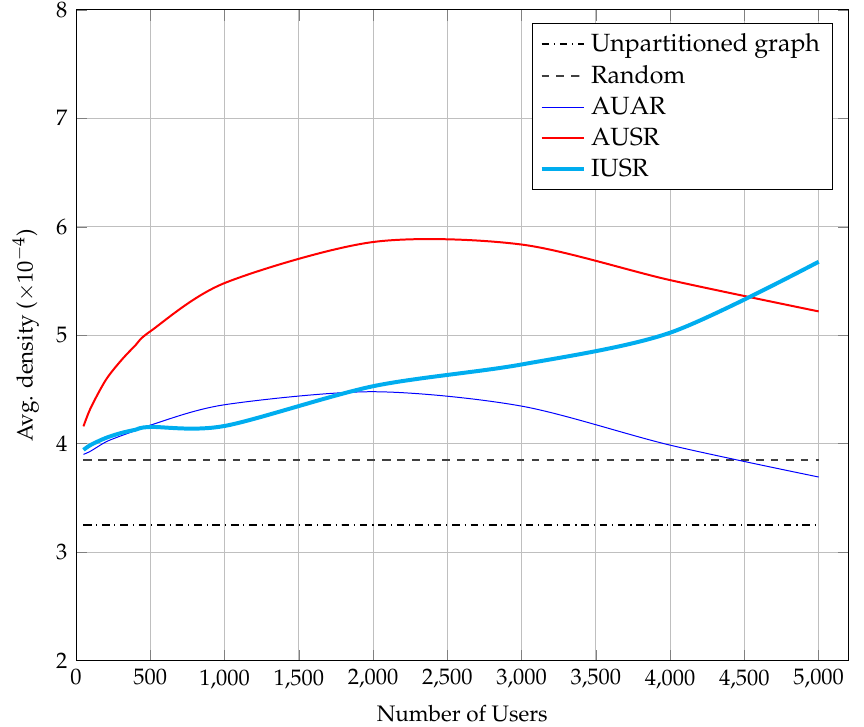
Figure 3. Average density per partition for different numbers of replicated users for the three